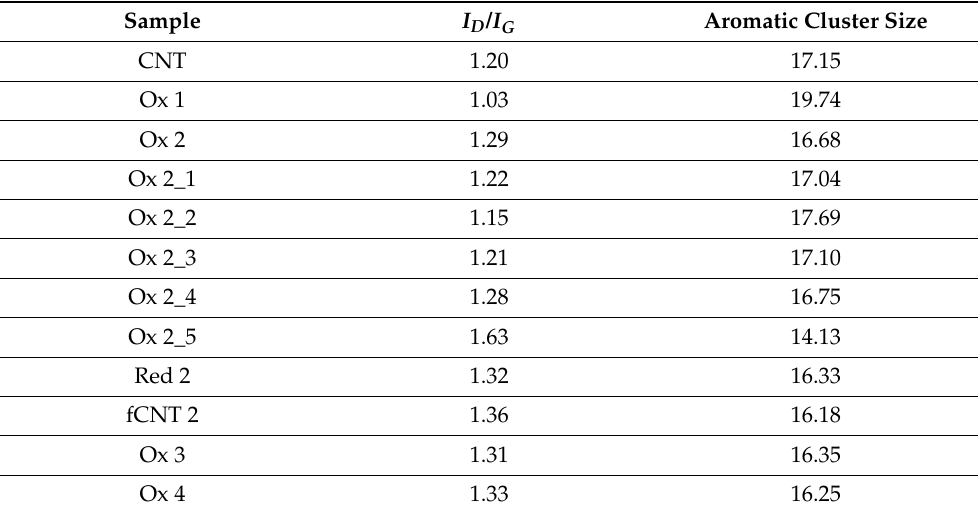
Table 3. Ratio of Raman-intensities I D /I G and aromatic cluster